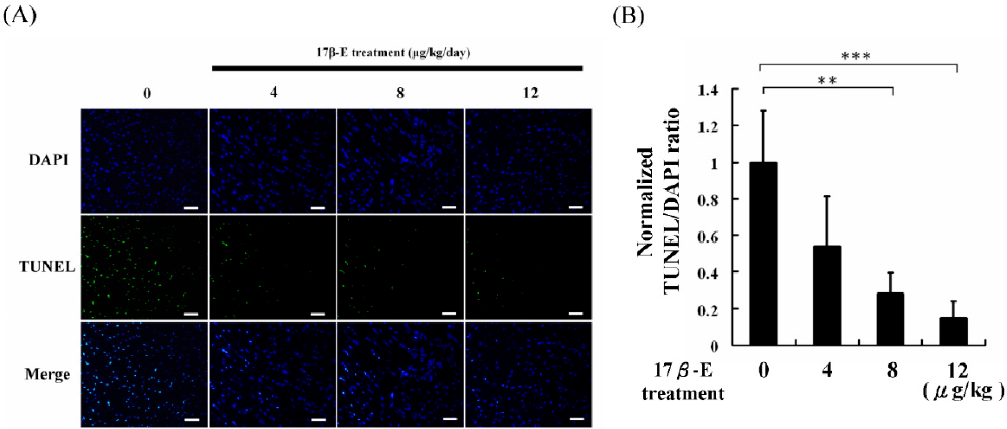
Figure 5. The cardiac apoptosis analysis of the heart slices from 60 days of different doses of 17 β -estradiol treatments (0, 4, 8, 12 µ g/kg/day) combined with high-fat diet-fed male C57B mice hearts. ( A ) DAPI and TUNEL staining assay were applied to all heart section samples. The nuclei of cells presented in blue color by DAPI stain, and the nuclei of apoptosis cells presented in green color by TUNEL stain (bar length = 50 µ m). ( B ) The apoptosis cell ratio in each group slice was presented in normalized TUNEL/DAPI fold. (** = p < 0.01, *** = p < 0.001 compared with the control, n = 6 in each group).